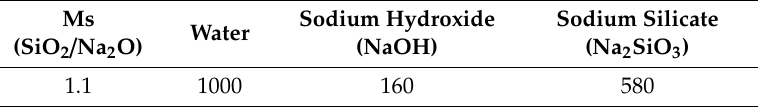
Table 2. Mix proportion of alkaline activator used in the present study